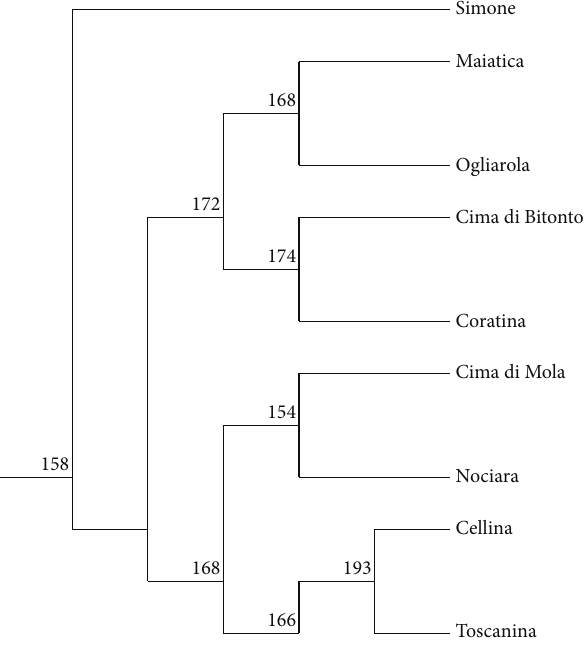
Figure 3: Identification key of nine olive cultivars obtained by the analysis of DCA18 microsatellite markers.